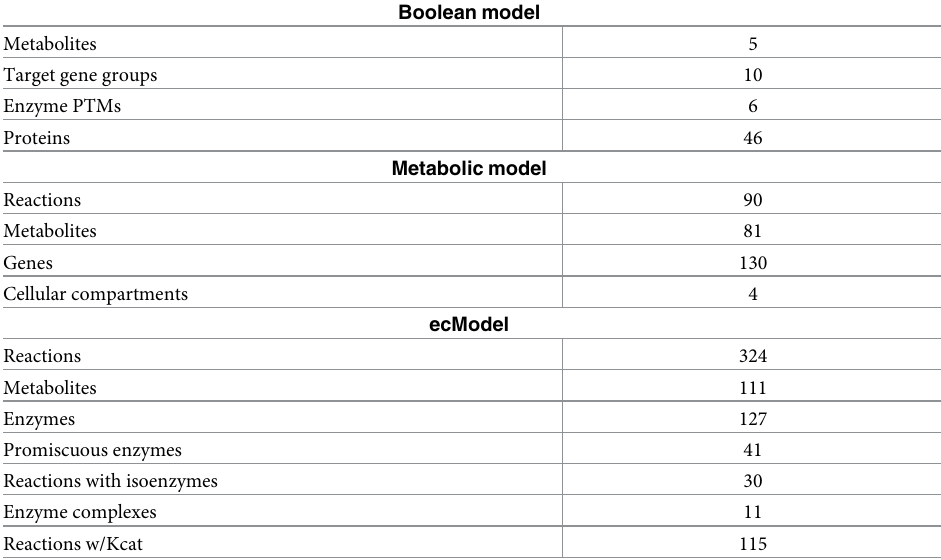
Table 1. Size metrics for the Boolean, original metabolic model, and its enzyme-constrained version. Boolean